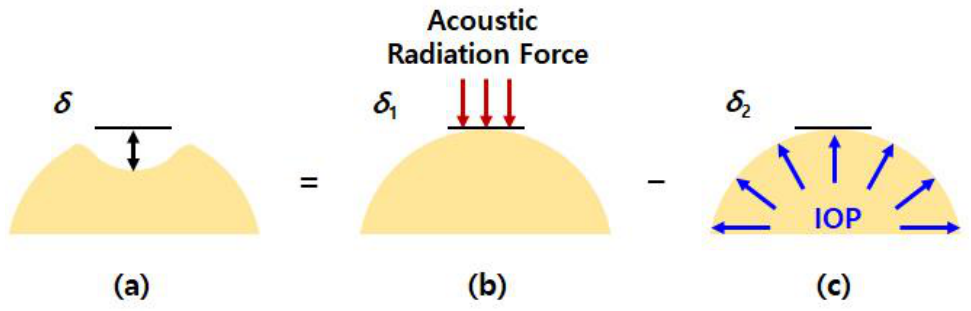
Figure 2. Schematic diagrams of the operational principle of the proposed technique: ( a ) final deformation δ is equal to the difference between ( b ) deformation δ 1 by the acoustic radiation force and ( c ) deformation δ 2 by the IOP.